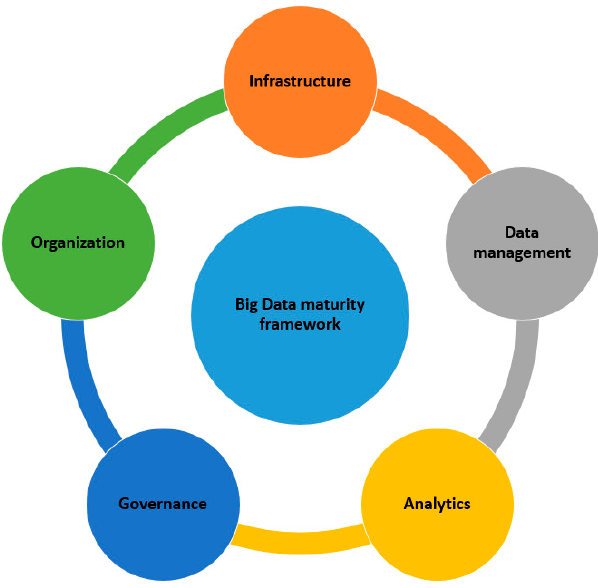
Figure 7. The dimensions of the TDWI Maturity Model.